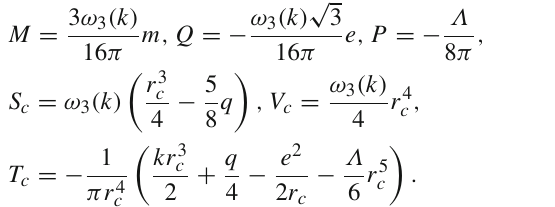
Based on the above equations, the f ( r ) − r diagrams could